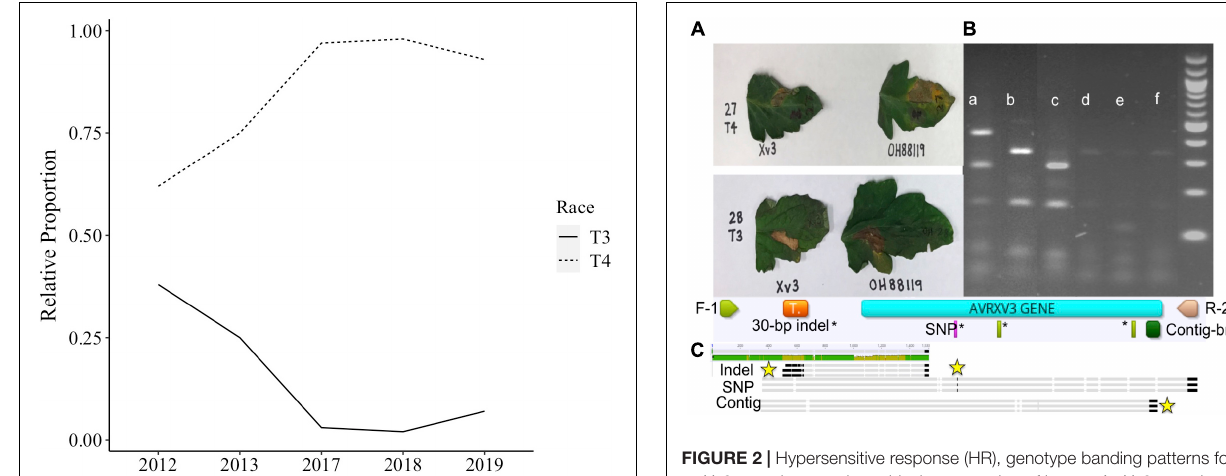
FIGURE 2 | Hypersensitive response (HR), genotype banding patterns for avrXv3 mutations, and graphical presentation of known AvrXv3 mutations. (A) Xv3 OH813A with Xv3/Rx4 inoculation elicits an HR in the presence of Xanthomonas perforans race T3 (lower panel) and not T4 (upper panel). OH88119 was utilized as a control to show susceptibility to both races. (B) Shows PCR amplification and banding patterns of X. perforans race T4 mutations and race T3. (a) X. perforans race T4 (Scott-1) digest band size 496, 280, and 164 bp, (b) X. perforans race T3 (SM761) digest band sizes 332 and 164 bp, (c) T4-SNP (1828-17) digest band sizes 280 and 164 bp (d,e) X. euvesicatoria (110C and 767), (f) X. hortorum pv. gardneri